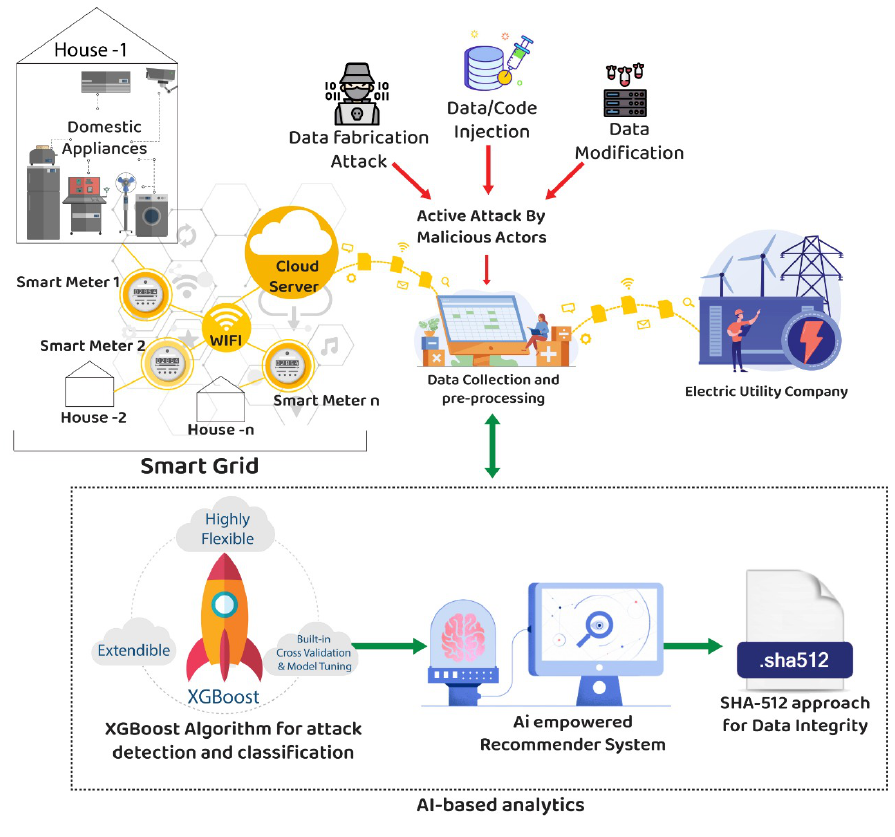
Figure 2. AI-ADP System